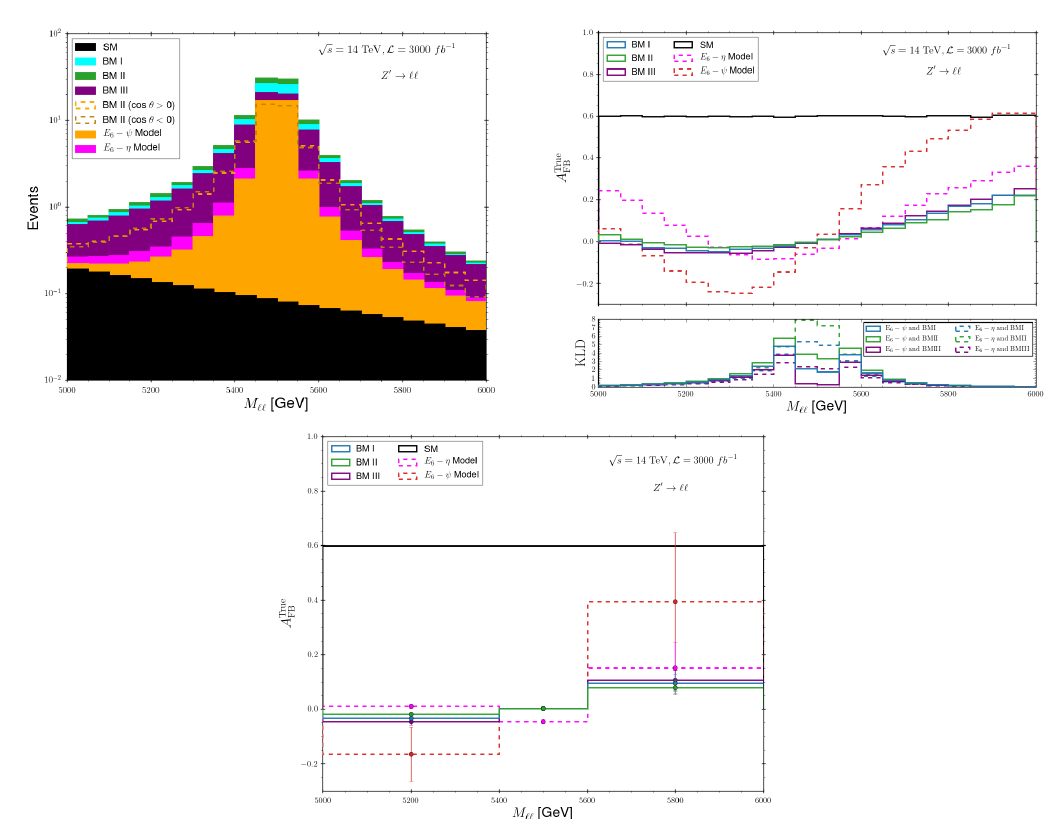
Figure 8 . Z 0 phenomenology at colliders. We depict signals from benchmarks BM I in blue, BM II in green, and BM III in purple. Top left: number of events in the NC DY channel versus the dilepton invariant mass within the SM, E models of ψ and η type and BM I , BM II and BM 6 III . For reference, BM II events are also given with cos θ > 0 and cos θ < 0 , where θ is the angle between the positively charged initial quark and negatively charged final state lepton. Top right: true A versus the dilepton invariant mass within the SM, E models of ψ and η type and BM FB 6 √ I , BM II and BM III . Results are given at the LHC with s = 14 TeV and L = 3000 fb − 1 for bin widths equivalent to the expected mass resolution in the cross section distribution while at the bottom plane the results are optimized so as to distinguish between various